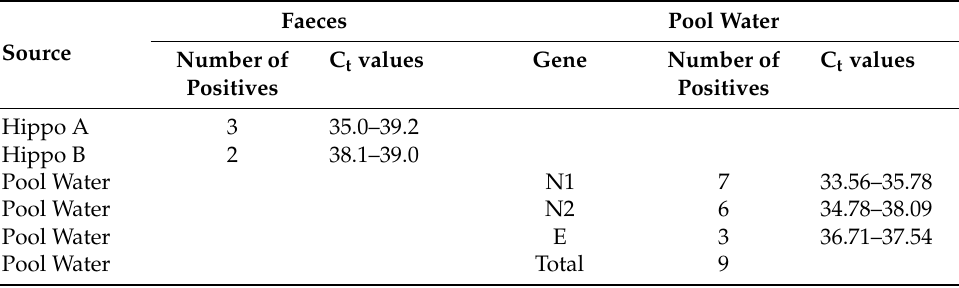
Table 1. PCR C t results of 23 faecal and 17 pool water